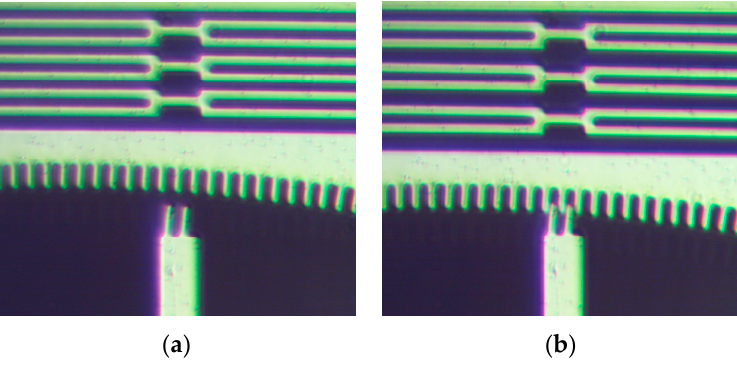
Figure 13. Locking mechanism: ( a ) Initial position and ( b ) latched position.